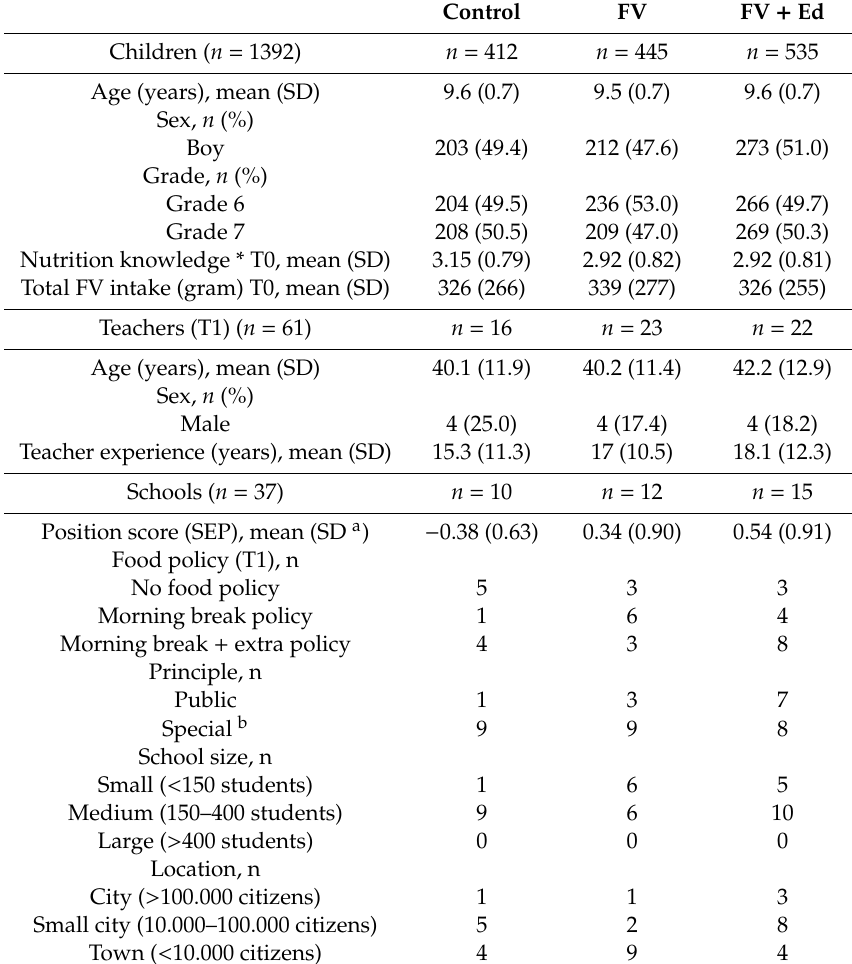
Table 3. Descriptive statistics of the children, teachers, and